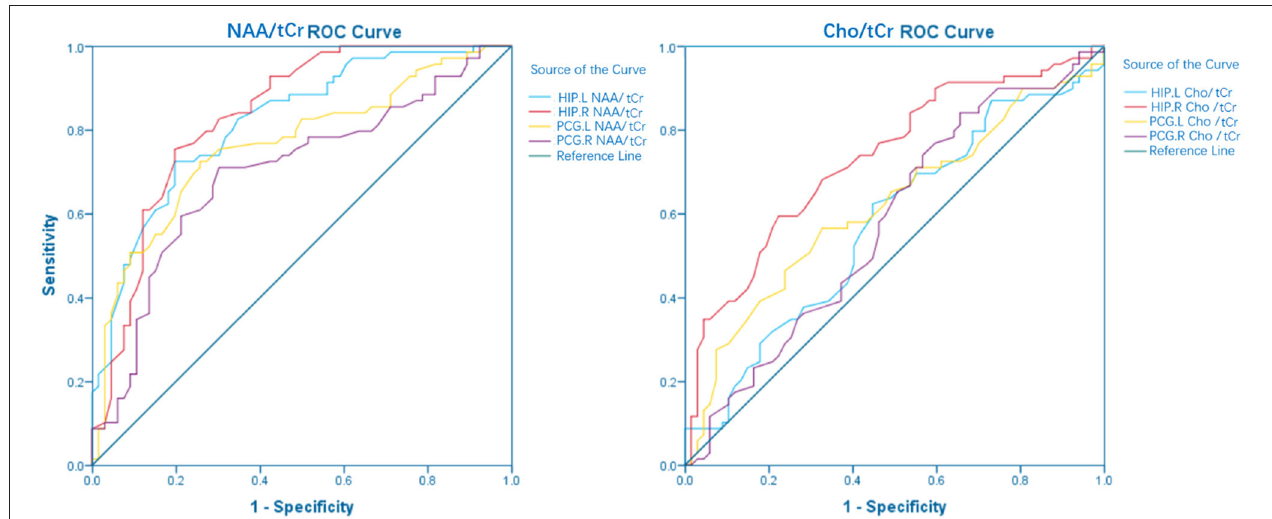
FIGURE 1 | Area under the receiver operating characteristic (ROC) curve and confidence interval (CI): hippocampus left (HIP.L) NAA/total creatinine (tCr): 0.819 (95% CI: 0.749–0.889) p < 0.001, HIP right (HIP.R) NAA/tCr: 0.834 (95% CI: 0.765–0.903) p < 0.001, posterior cingulate gyrus left (PCG.L) NAA/creatine (Cr): 0.764 (95% CI: 0.683–0.846) p < 0.001, PCG right (PCG.R) NAA/tCr: 0.698 (95% CI: 0.608–0.788) p < 0.001, HIP.L choline (Cho)/tCr: 0.574 (95% CI: 0.477–0.670) p = 0.137, HIP.R Cho/tCr: 0.731 (95% CI: 0.647–0.816) p < 0.001, PCG.L Cho/tCr: 0.617 (95% CI: 0.522–0.712) p = 0.019, PCG.R Cho/tCr: 0.576 (95% CI: 0.479–0.672) p = 0.128.